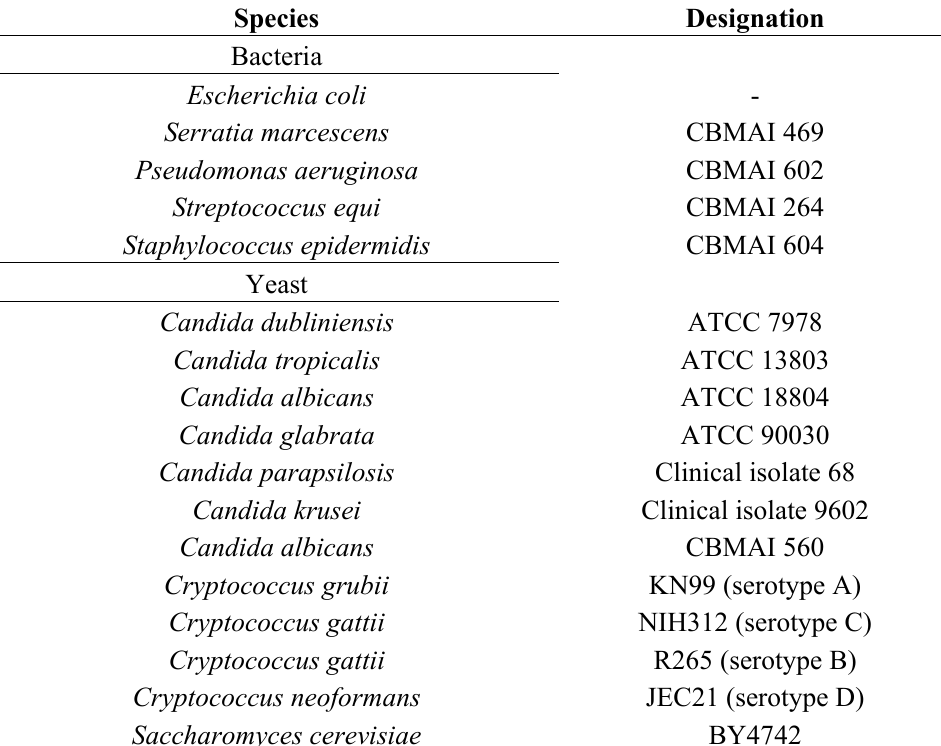
Table 3. Target strains used for antimicrobial activity